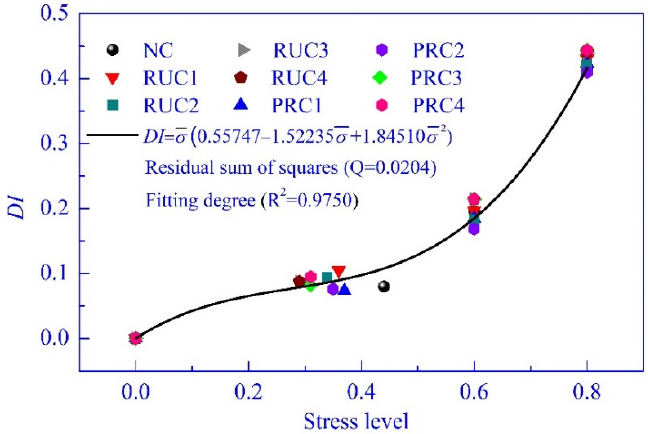
Figure 11. The test values of DI and prediction equation.